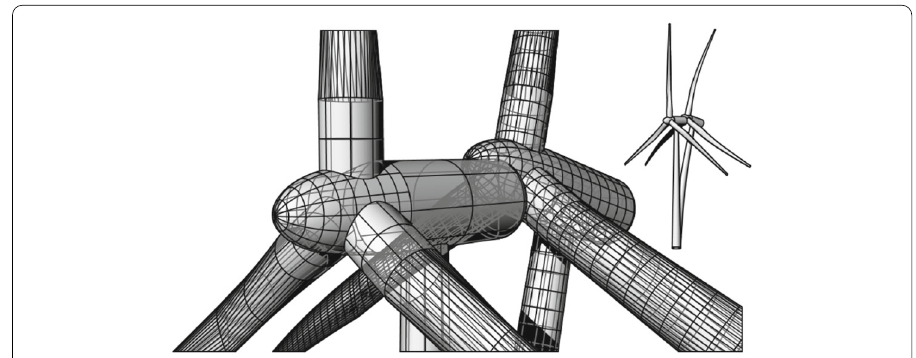
Fig. 14 Displacement of a wind turbine under wind